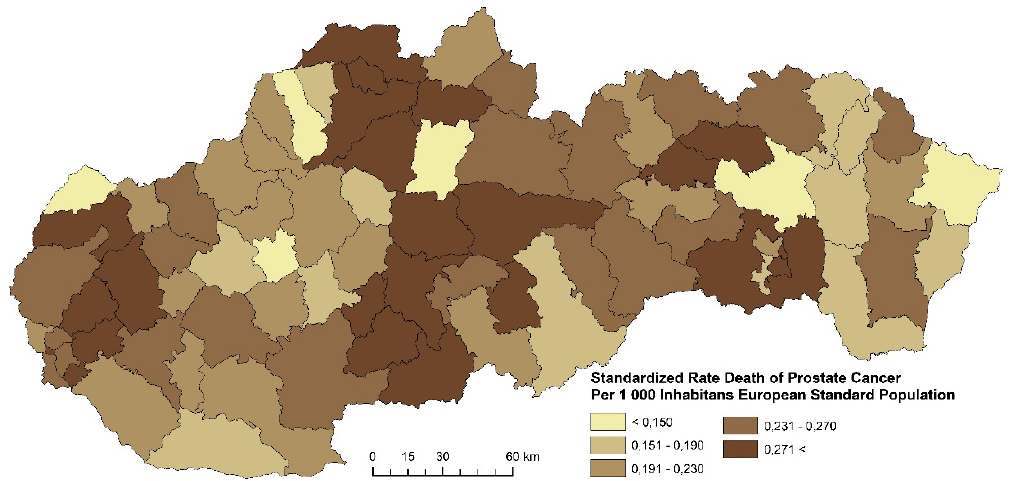
Figure 17. Standardized death rate of prostate cancer per 1000 inhabitants of European Standard Population, 2001–2006. Source: Statistical Office of the Slovak Republic, 2019.